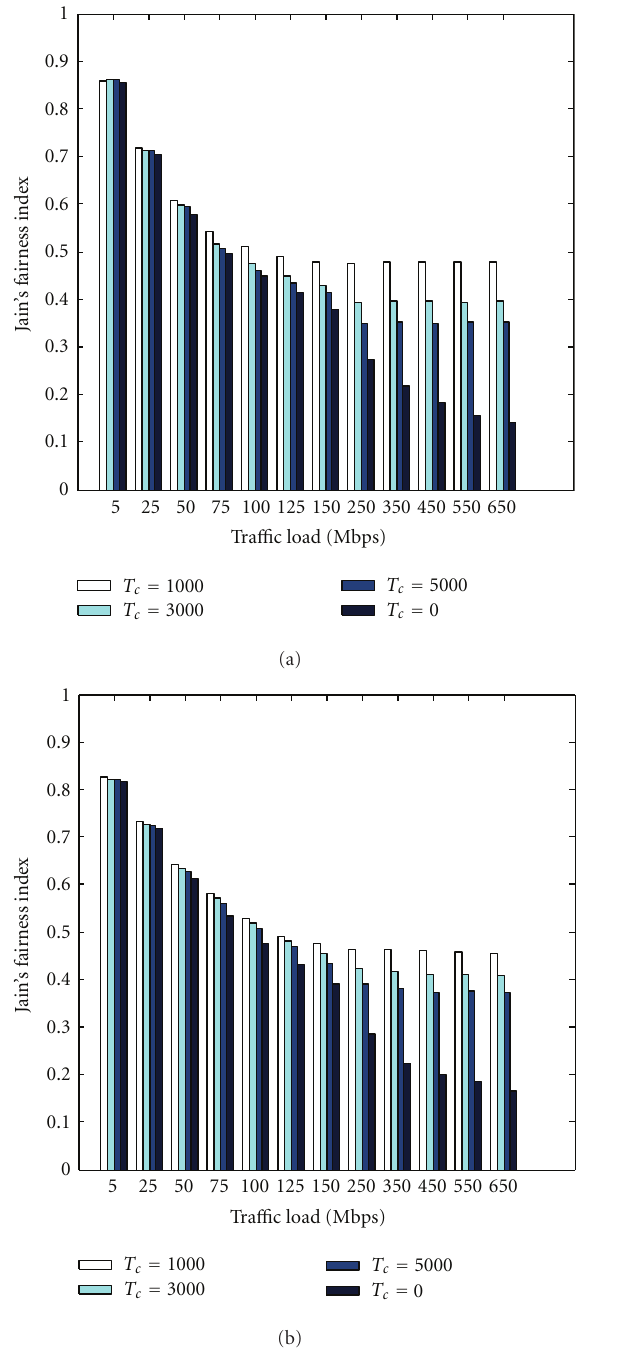
Figure 3: Fairness index of the PF scheduling with (a) OFDMA (b) OFDM.